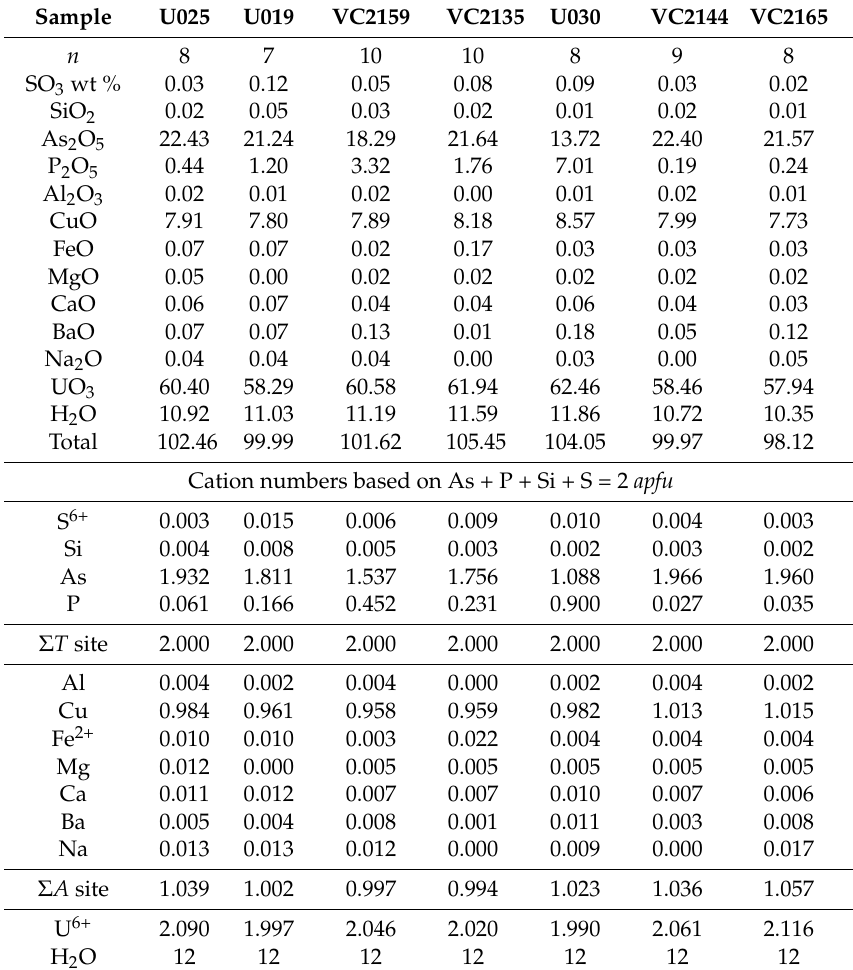
Table 1. Chemical composition of